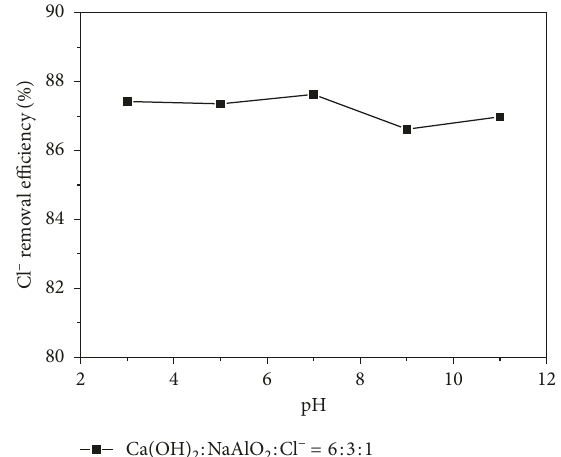
Figure 4: The effect of the solution’s initial pH. Figure 5: The effect of the solution’s